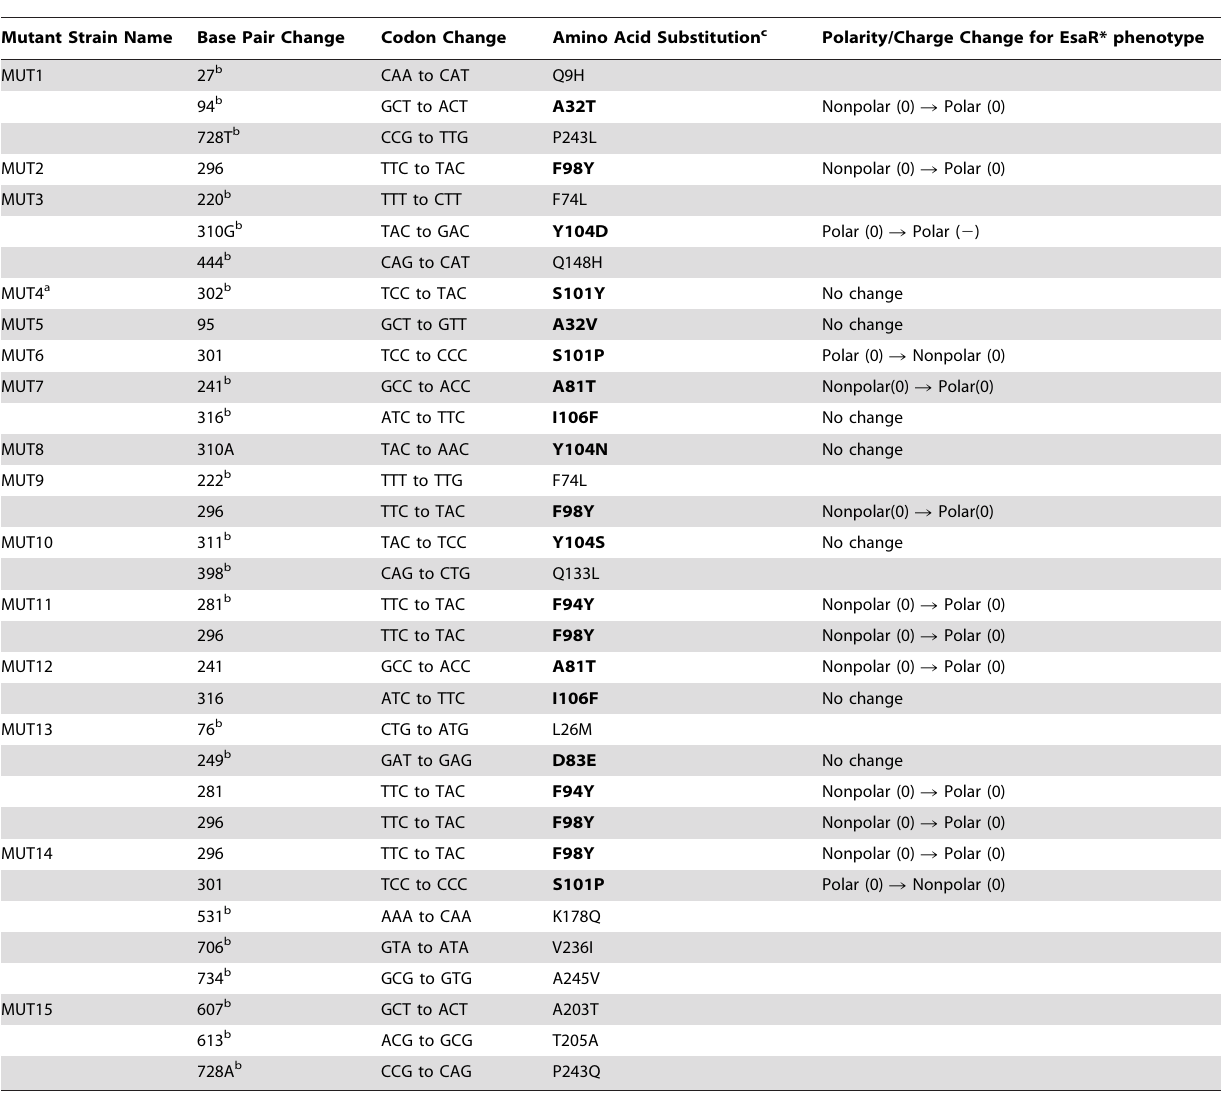
Table 2. Comprehensive list of mutations achieved in error-prone PCR and the resultant amino acid changes.